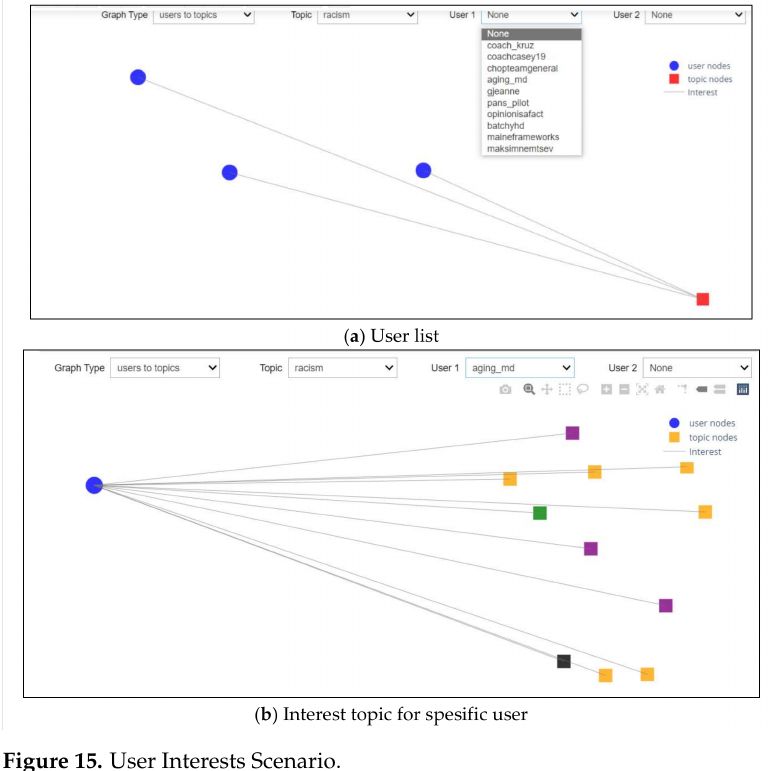
Figure 15. User Interests Scenario.